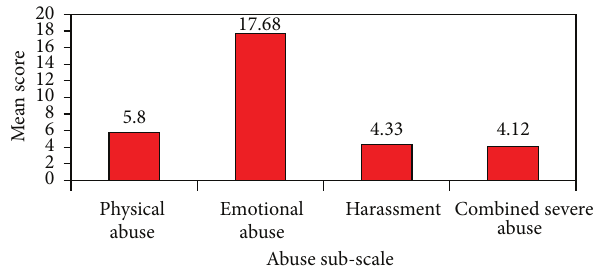
Figure 2: Mean scores for composite abuse scale